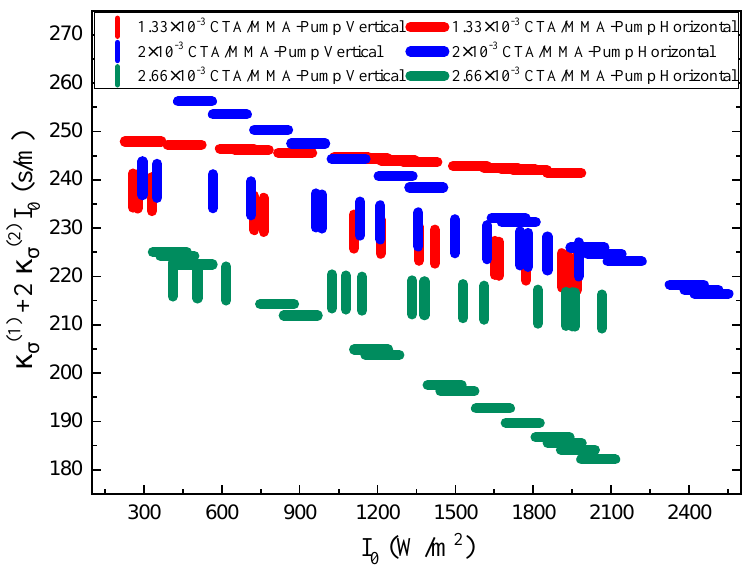
Figure 12 shows the photomechanical response as a function of intensity calculated from Equation (36) at the measured intensities using the fit parameters κ Table 3. The intensity-dependent response for pump light polarization along the axis containing the force sensor (which we will call vertical) changes by less than or equal to approximately 10%. The heating model given by Equation (7) predicts that the change in stress induced by the photothermal heating mechanism is independent of the intensity. The data for vertically polarized pump light, thus, shows that heating is responsible for at least 90% of the observed photomechanical response.